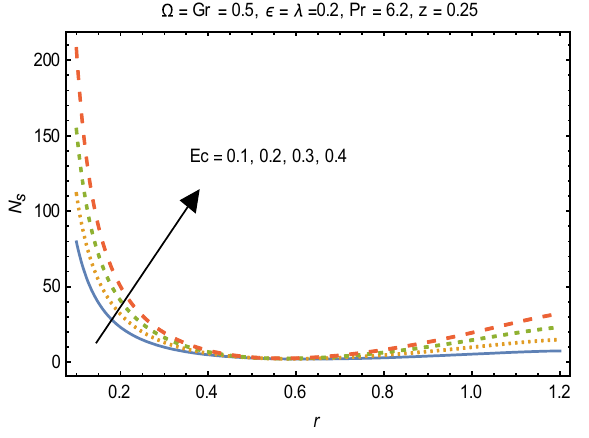
Figure 11. Variation in N s for Ec .